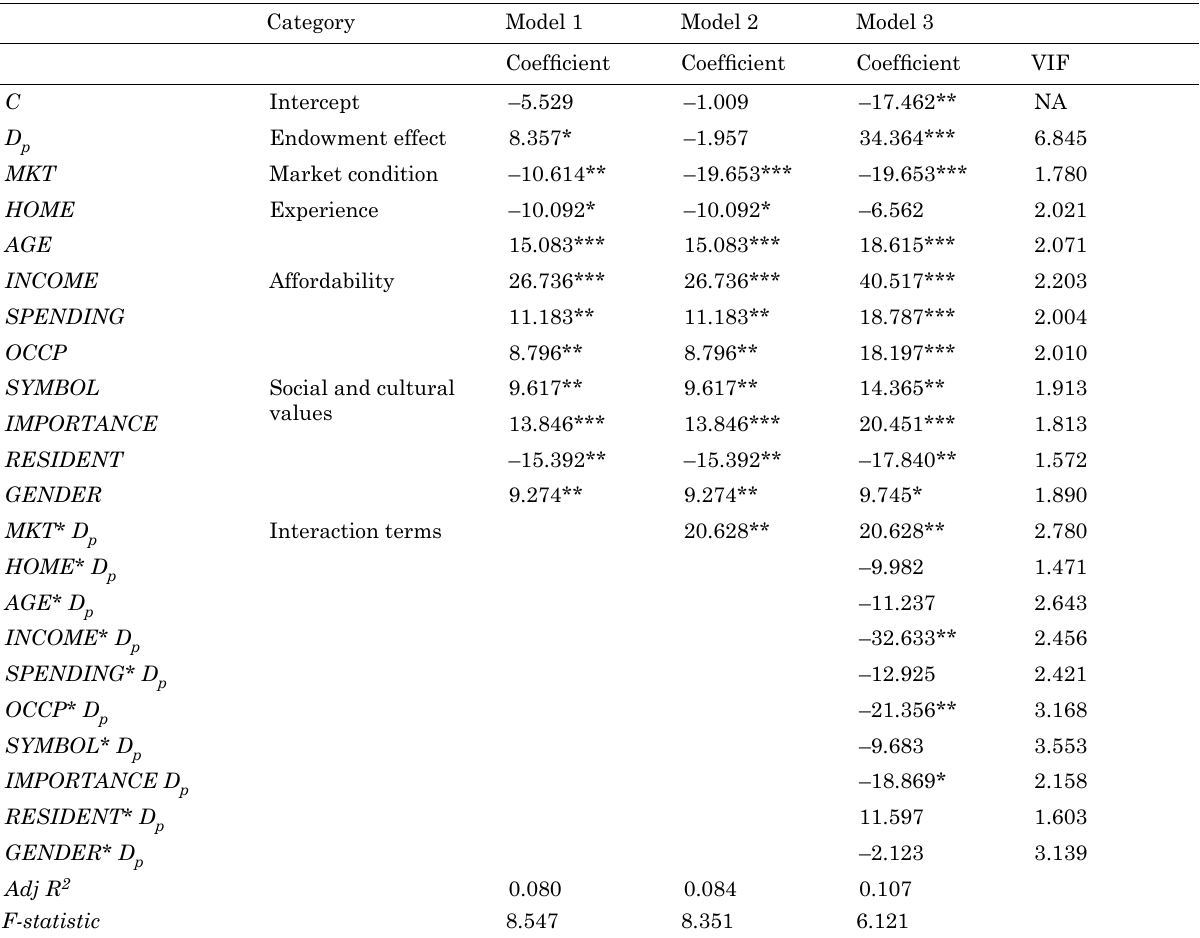
table 4. regression